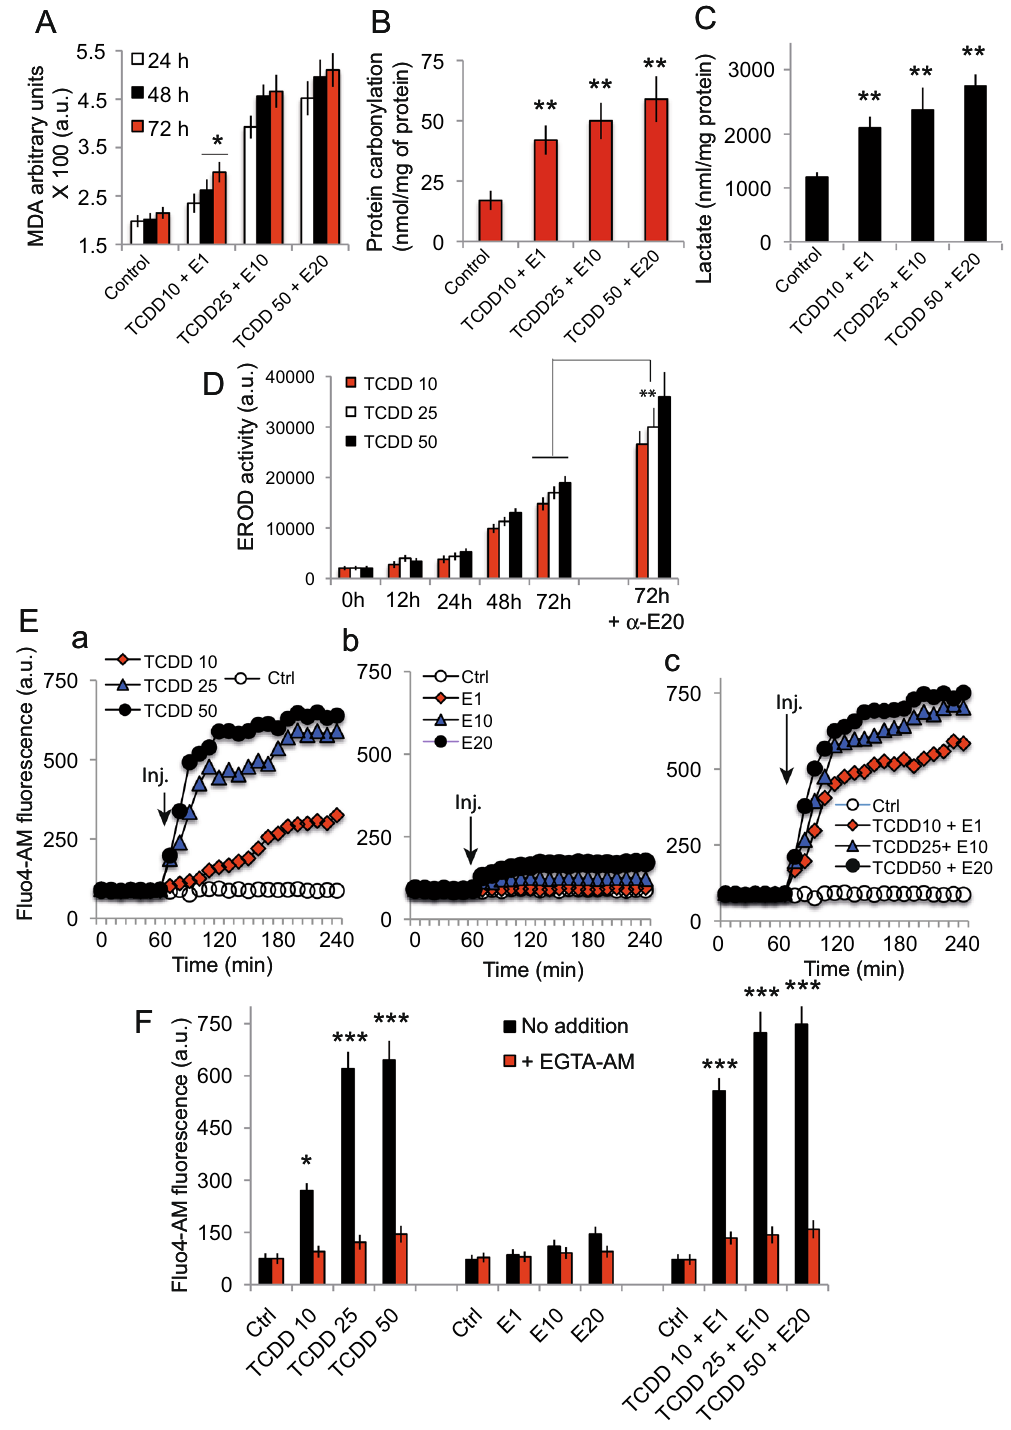
Figure 2. Diverses cellular activities linked to the pollutant cocktail treatment. ( A ) Malondialdehyde production as a function of time (24 h, 48 h and 72 h) and TCDD + E concentration (n = 5). ( B ) Protein carbonylation in cells treated with the indicated concentrations of pollutant cocktails, after 48 h incubation (n = 6). ( C ) Lactate production induced by the treatment of Caco-2 cells after 48 h treatment with different pollutant cocktails. The data are expressed as nmol/mg protein (n = 7). ( D ) EROD activity linked to TCDD treatment at different concentration and an example of the synergistic action of TCDD + α -E at 48 h incubation (n = 5). ( E ) Calcium rise induced by the individual pollutants (i.e, TCDD or endosulfan) or the pollutant mixtures at different concentrations in presence or absence of EGTA-AM during the 4 hours following exposure (n = 7). ( F ) Histograms of the calcium content of the cells after treatments (similar to E) but at 48 h in presence or absence of EGTA-AM (n =